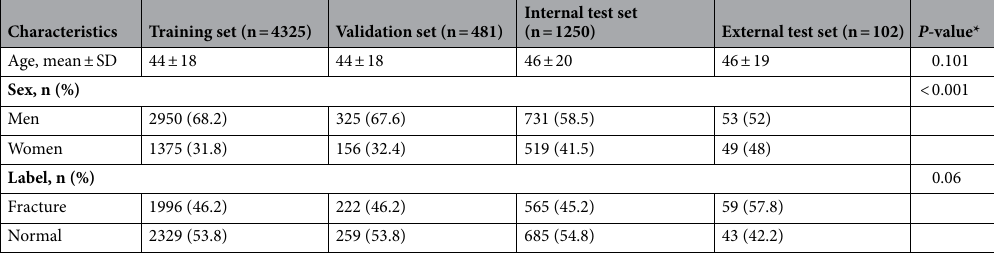
Fig. 1b. Example radiographs of correctly diagnosed nasal bone fractures with Grad-CAM heatmaps are shown in Fig. 2. The nasal bone area was properly highlighted in the heatmap in both views for most patients (n = 90). For nine of the remaining 12 subjects, the nasal bone was highlighted in only one view while the nasal bone was not highlighted in both views in three patients. Additionally, examples of normal nasal radiographs incorrectly diagnosed as fractures by the DL model are shown in Fig. 3.